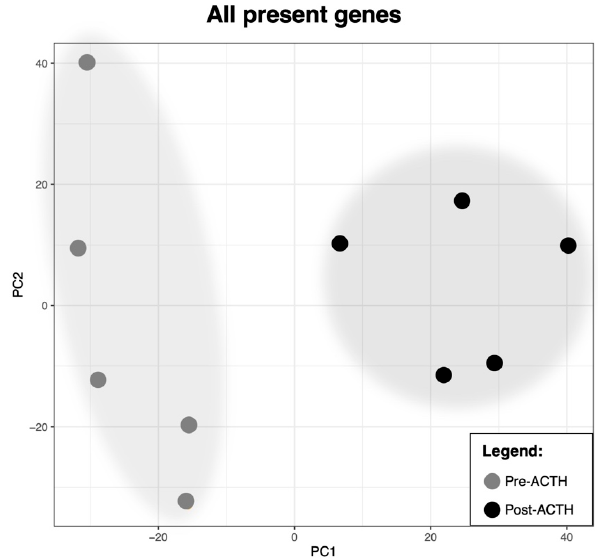
Figure 1. Principal component analysis (PCA) plot of all samples related to all detected transcribed genes. Sample distribution following the principal component 1 (PC1) appears to be prompted by the presence or absence of treatment.